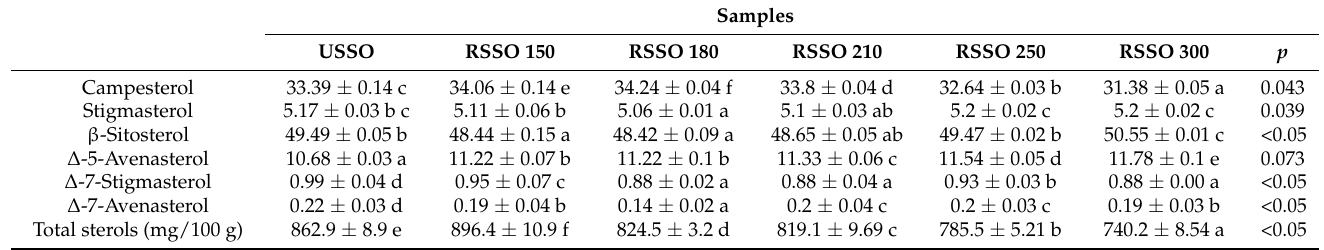
Table 5. Sterol contents (relative% and total amount) of raw and roasted sesame seed oils at different temperatures.